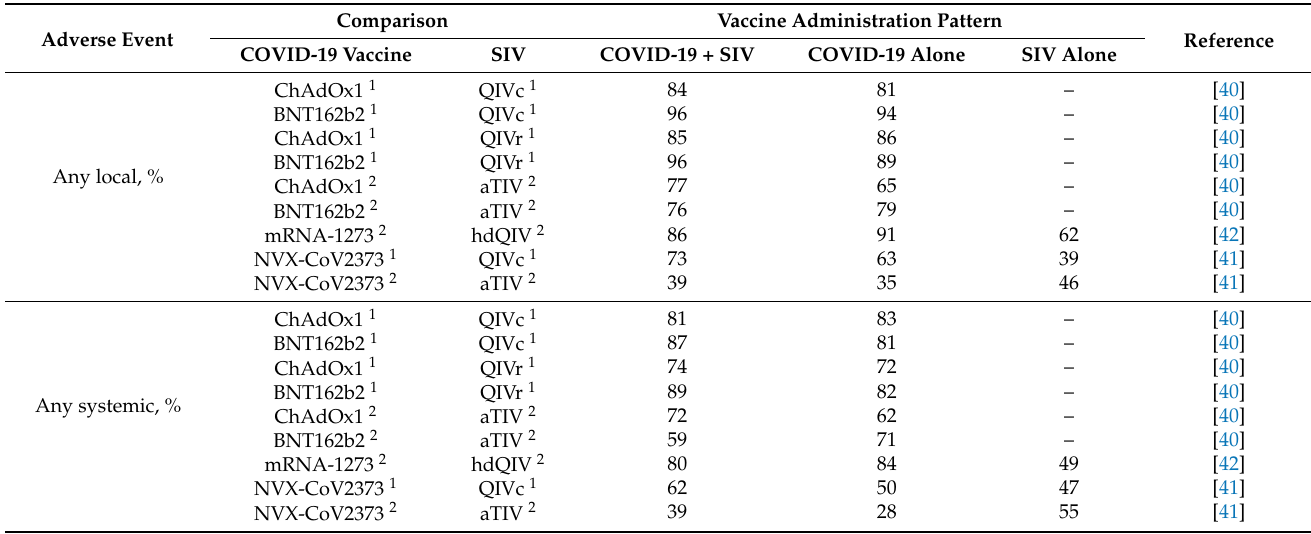
Table 1. Rate (%) of solicited local and systemic adverse events in COVID-19 and influenza vaccine co-administration groups, as compared with groups to whom either vaccine was administered